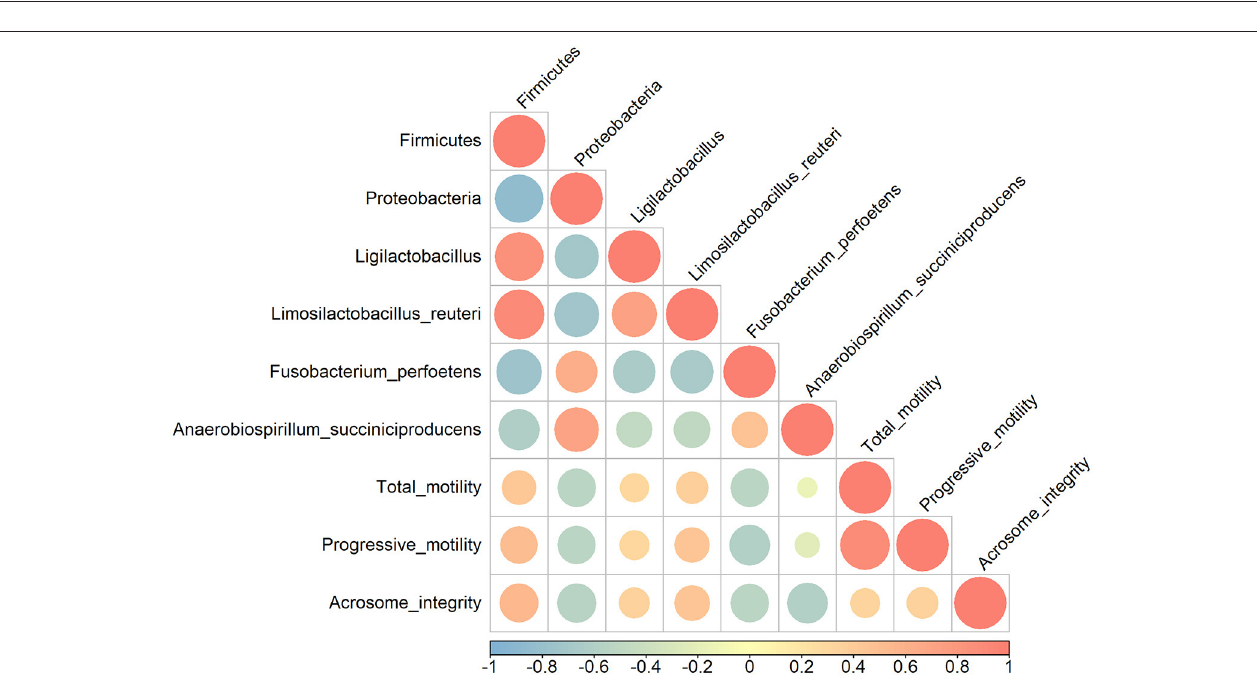
FIGURE 2 | Pearson correlation analysis between relative abundance of bacterial phyla and species, and sperm qualitative parameters. Coefficients are colored from light blue (negative correlation) to light red (positive correlation), and color intensity and circle sizes are proportional to the level of correlation.